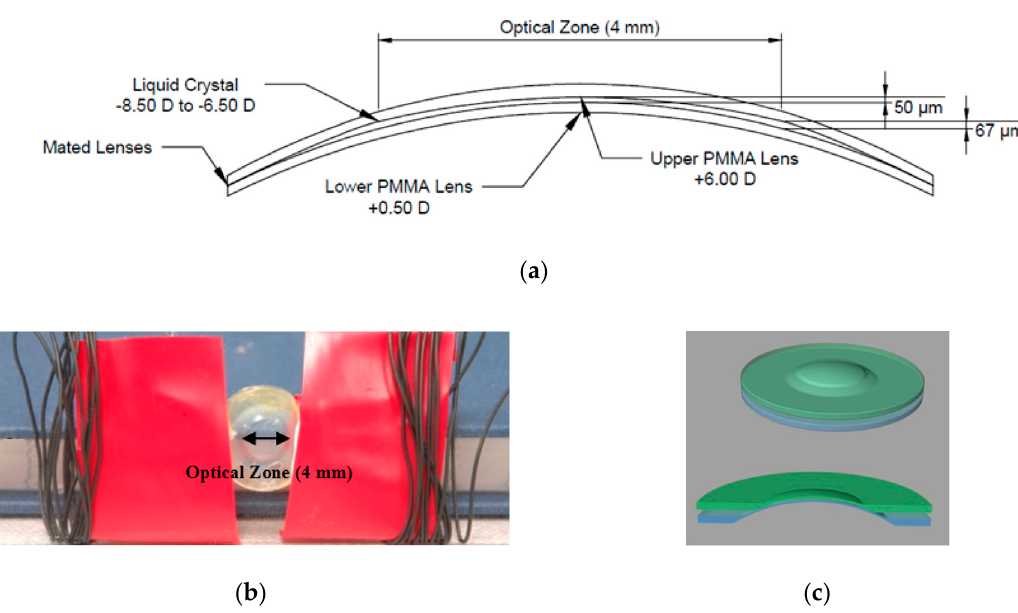
Figure 7. ( a ) Shows a diagram of the design used for the switchable LC lens. The base curve of the lens is designed to fit onto the eye, with a radius of curvature of 7.8 mm, and therefore, appropriate for the average human cornea. The optical power of the lower substrate is +0.50 D, the optical power of the upper substrate is +6.00 D, with the optical power of the LC layer varying between − 8.50 D and − 6.50 D, depending on the polarization direction of light and the orientation of LC molecules. ( b ) A photograph of the device. ( c ) CAD rendered images of the lens. Reprinted with permission from [134]. Copyright 2014 Optical Society of